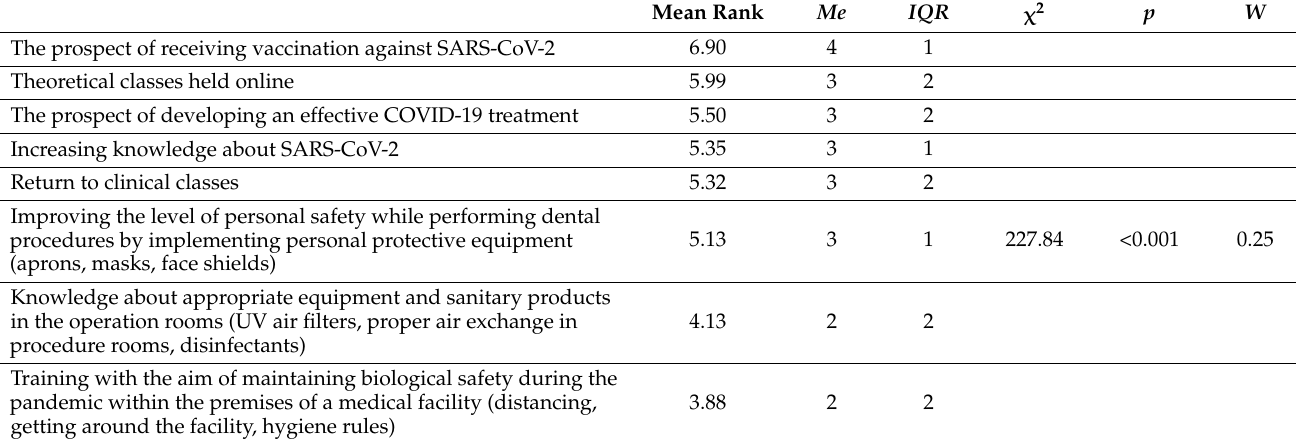
Table 3. Clinical education: Friedman’s analysis comparing the impacts of implemented preventive activities on stress perception among students of dentistry at JUMC in their third, fourth, and fifth years of study during the COVID-19 pandemic. Legend: Me —median, IQR —interquartile